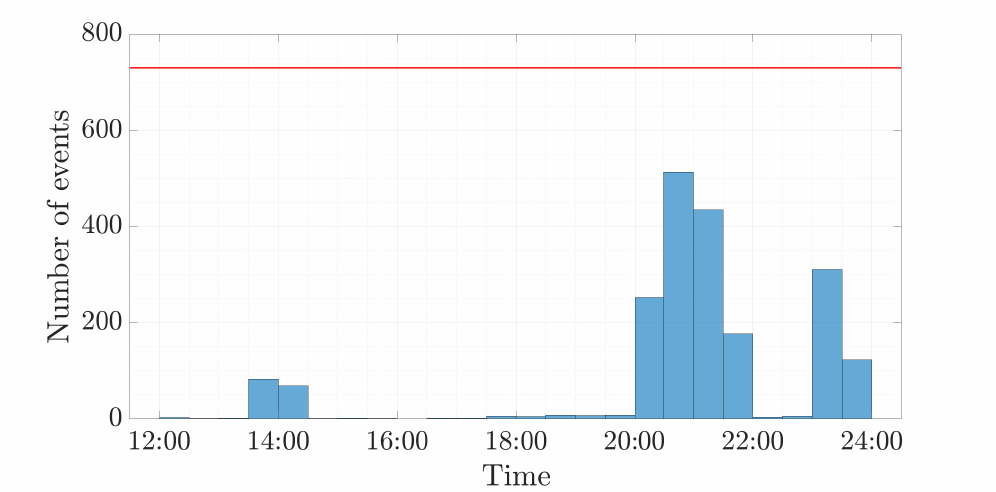
Figure 6. Time of the day with overloading of the